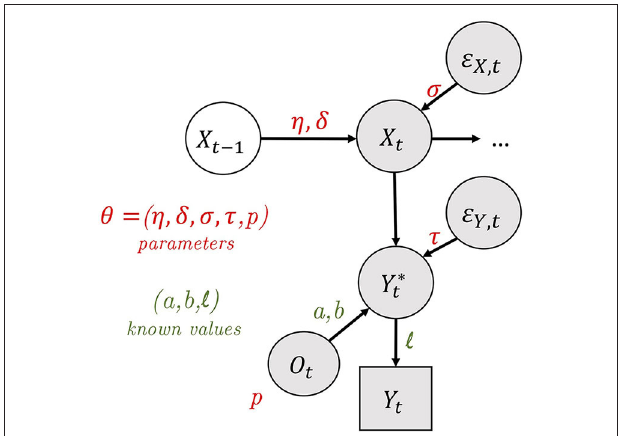
FIGURE 1 | Diagram of the proposed auto-regressive model. ( X t ) t ∈{ 1, ... , n } is the underlying auto-regressive process (to be recovered), ( Y t ) t ∈ T is the measured quantity process, Y ∗ t a non-censored version of Y t , O t is the indicator variable for the event “ Y ∗ t is an outlier,” ε X , t are tiny innovations and ε Y , t are the measurement